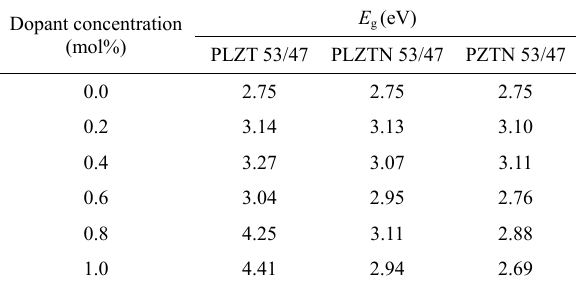
Table 3 Experimental optical band gap energy